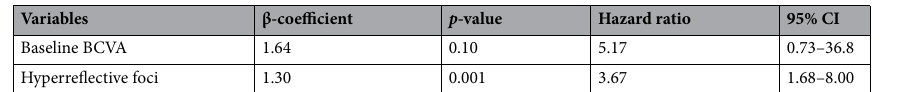
Table 4. Cox regression analyses associated with macular neovascularization (repeated forward selection method). Age, sex, drusenoid pigment epithelial detachment, pseudodrusen, baseline subfoveal choroidal thickness, ARMS2 A69S, and CFH I62V were eliminated in this analysis. BCVA, best-corrected visual acuity.